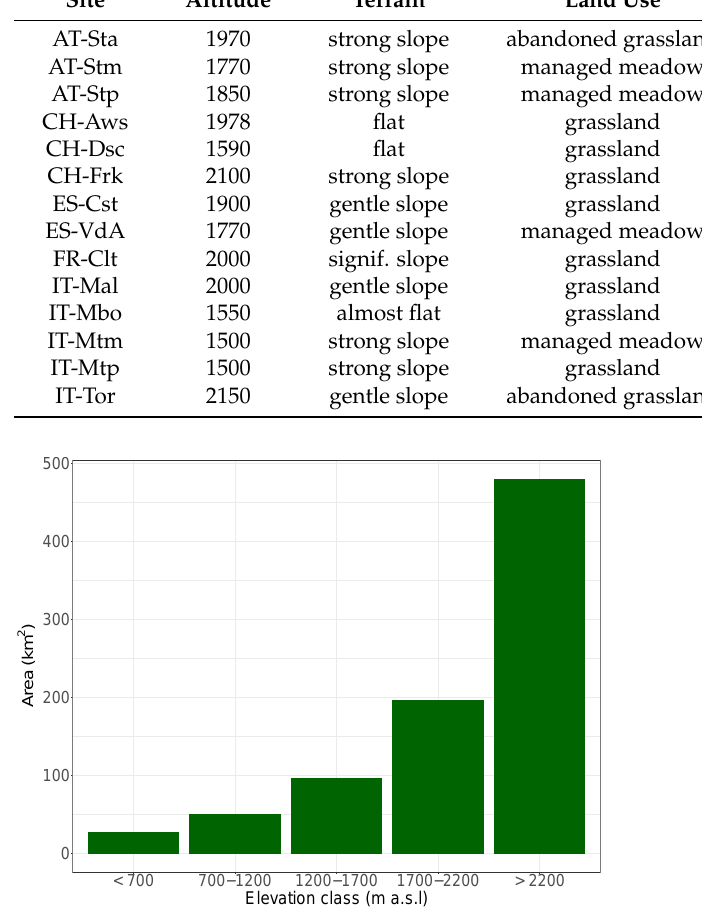
Figure A2. Distribution of grassland areas in Aosta Valley for different altitude